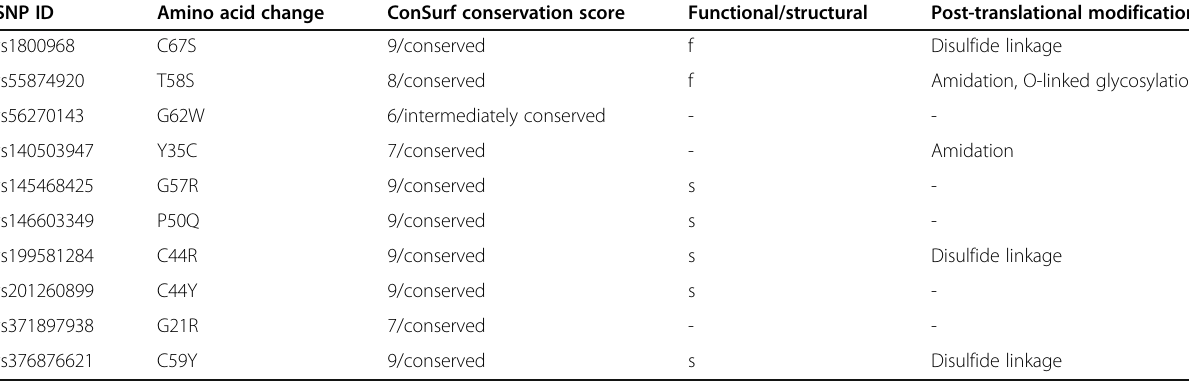
Table 3 Prediction of phylogenetic conservation and post-translational modifications